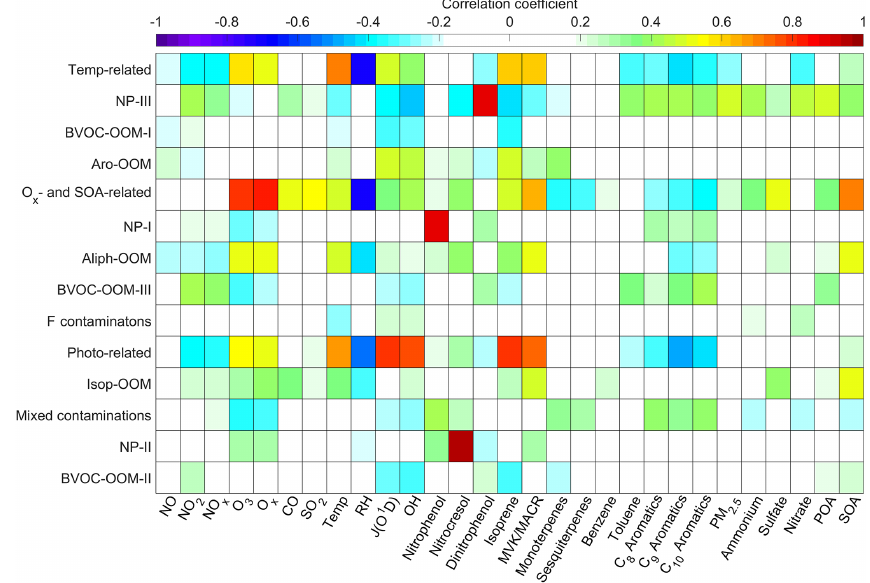
Figure 5. Correlations of PMF factors with external gas-phase and particulate tracers from other instruments deployed at the SORPES station, with the color representing the Pearson correlation coefficients. From left to right, the tracers are gas-phase species (NO, NO 2 , NO x , O 3 , CO, SO 2 ), meteorological data (temperature (Temp), relative humidity (RH), photolysis constants ( J( O 1 D ) )), nitrate CI-APi-TOF data (OH, nitrophenol, nitrocresol, dinitrophenol), PTR-TOF-MS data (isoprene, methyl vinyl ketone–methacrolein (MVK–MACR)), monoterpenes, sesquiterpenes, benzene, toluene, C 8 aromatics, C 9 aromatics, C 10 aromatics), PM 2 . 5 , and ACSM data (ammonium, sulfate, nitrate, POAs,